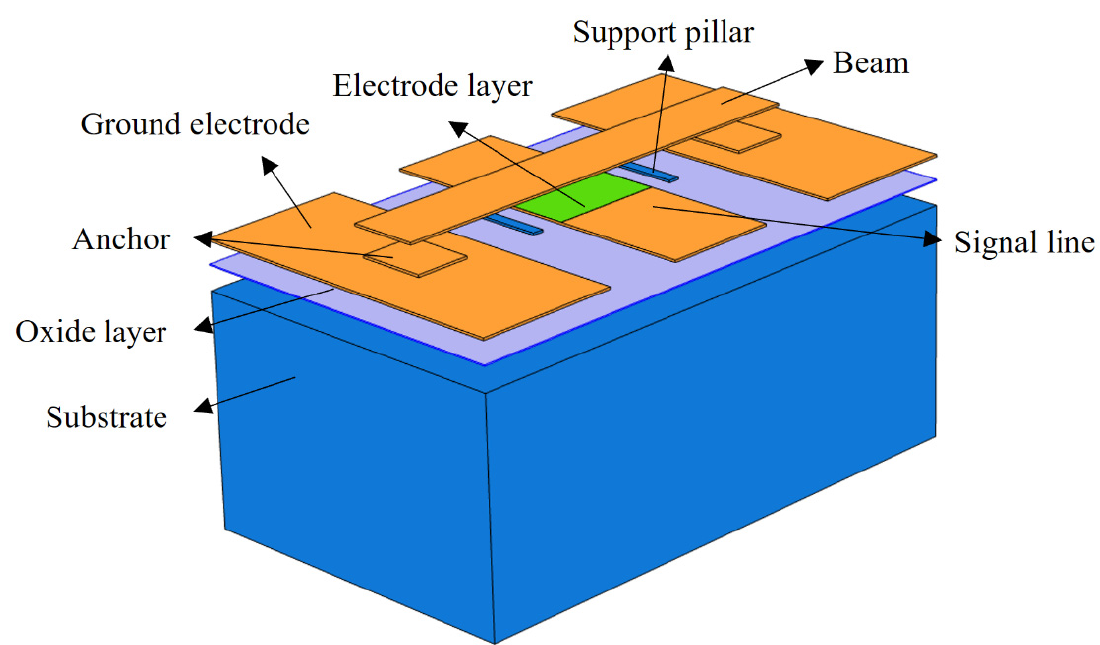
Figure 3. Schematic view of the proposed RF MEMS device.